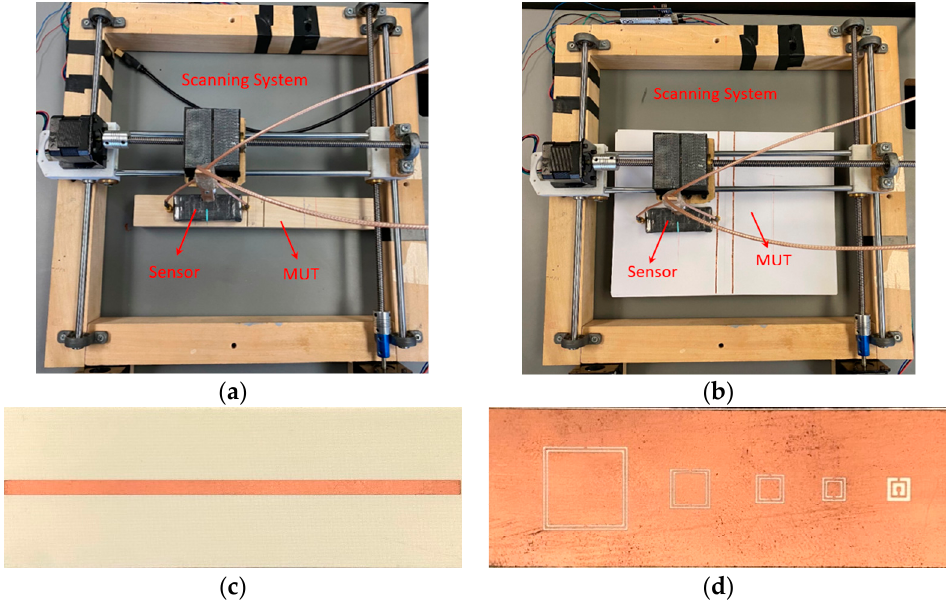
Figure 10. Main components of the microwave imaging system with: ( a ) wood with defects as MUT, ( b ) a pile of paper with copper strips as MUT, ( c ) front view of the multifrequency near-field sensor, and ( d ) back view of the multifrequency near-field sensor.